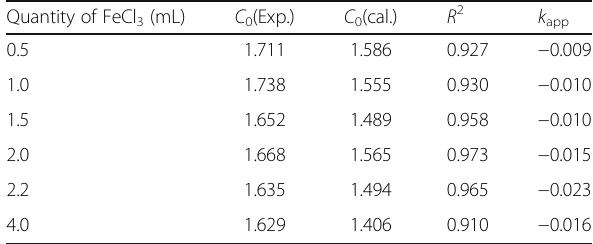
Table 1 Pseudo-first-order kinetic parameters of As(III) photocatalytic oxidation